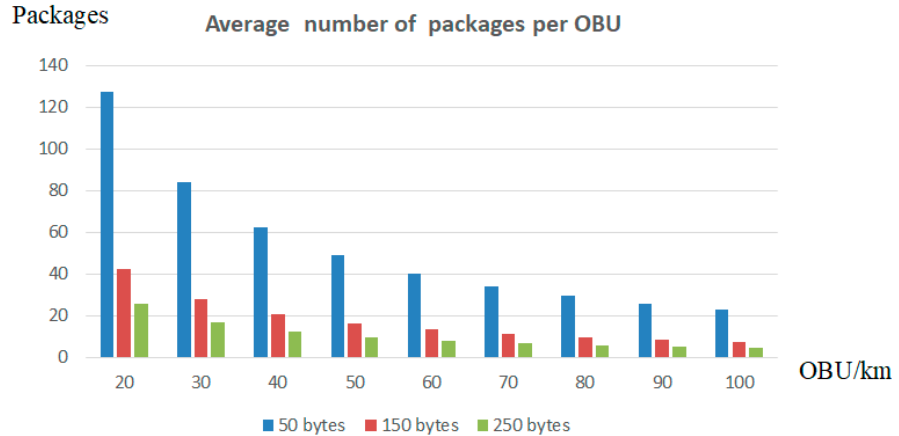
Figure 2. Dependence of the average number of packets per OBU on road traffic intensity with maximal level of confidentiality and a 32-bit protocol.